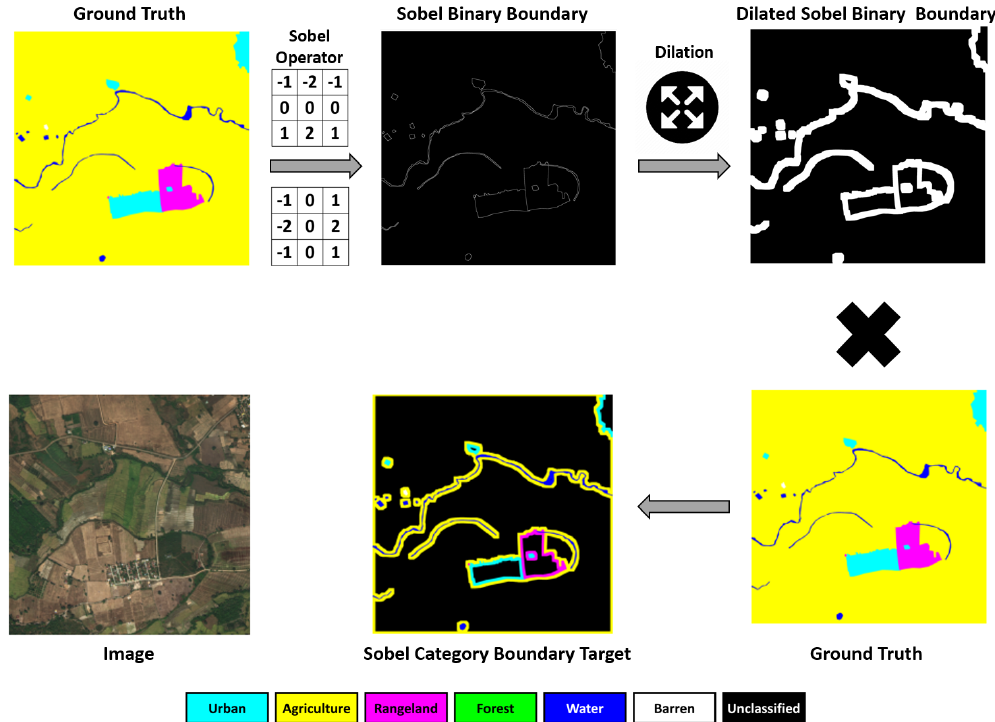
Figure 7. The procedure of generating Sobel category boundary target; dilation rate: d = 50